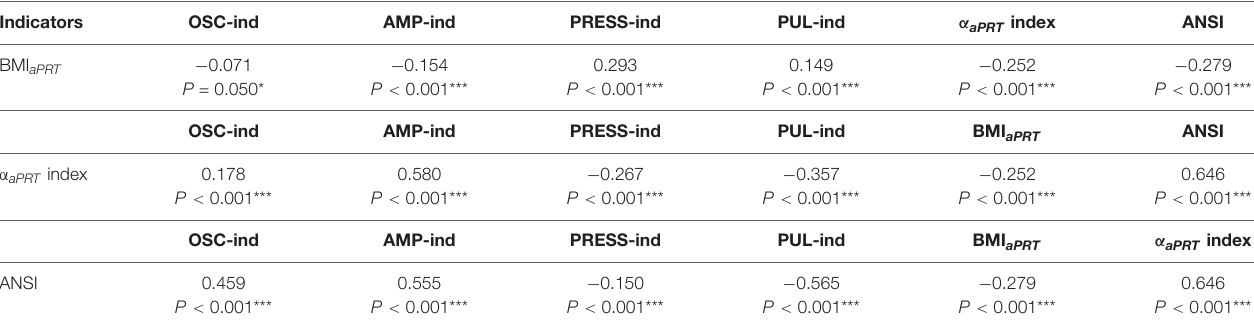
TABLE 5 | Correlation coefficients of BMI aPRT , the α aPRT index, and ANSI with the four ANS indicators, and p -values of the tests for null correlation.